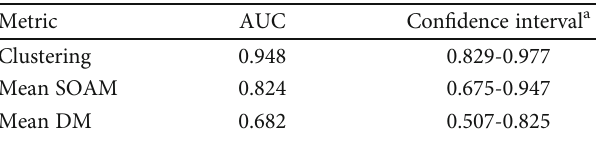
Table 3: Tortuosity and clustering ROC area under the curve